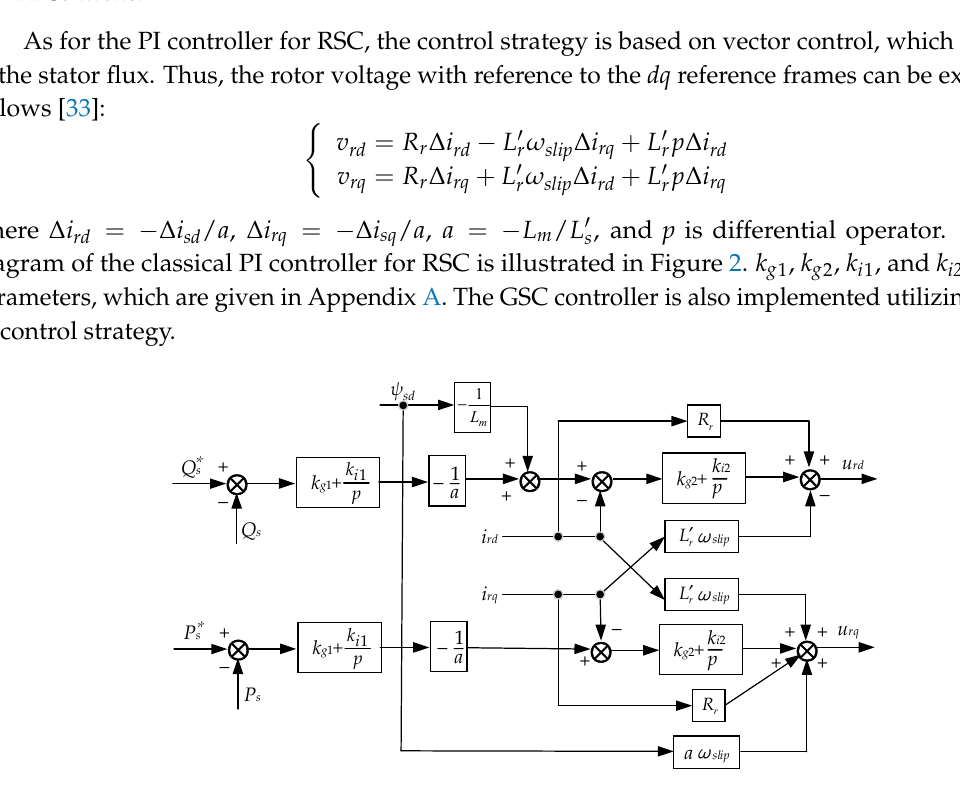
Figure 2. Implementation block diagram of the PI controller for rotor side converter (RSC).